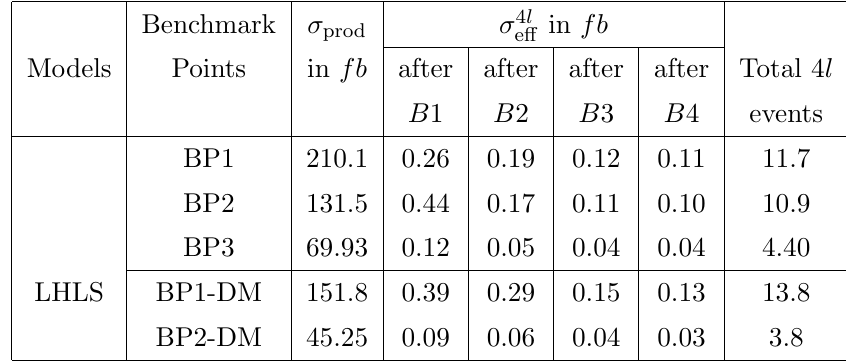
Table 13 . The production cross-sections of all EWeakino pairs and (cid:27) 4 l and table 7. Also the total number of 4 l events are shown for an integrated luminosity of 100 fb (cid:0) 1 .